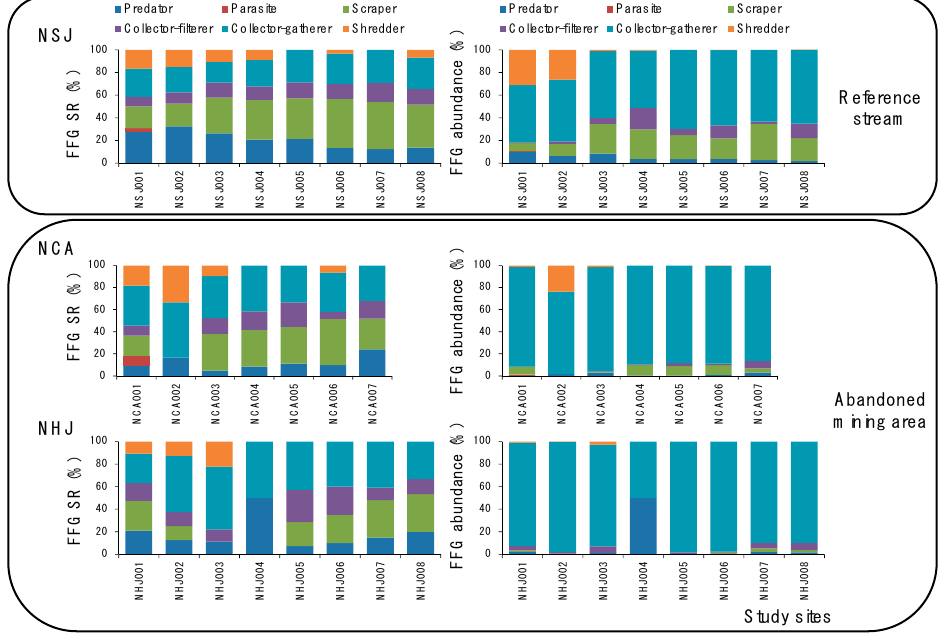
Figure 4. Differences in functional feeding group (FFG, %) based on abundance and species richness (SR) in streams in reference sites and abandoned mining area (NSJ: Songjeonrichoen stream, NCA: Cheulamcheon stream and NHJ: Hwangjicheon stream).